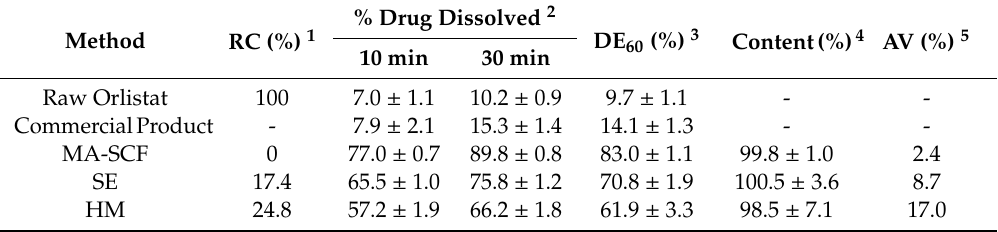
Table 5. Evaluated pharmaceutical characteristics of orlistat-loaded Neusilin ® UFL2 prepared by various methods.